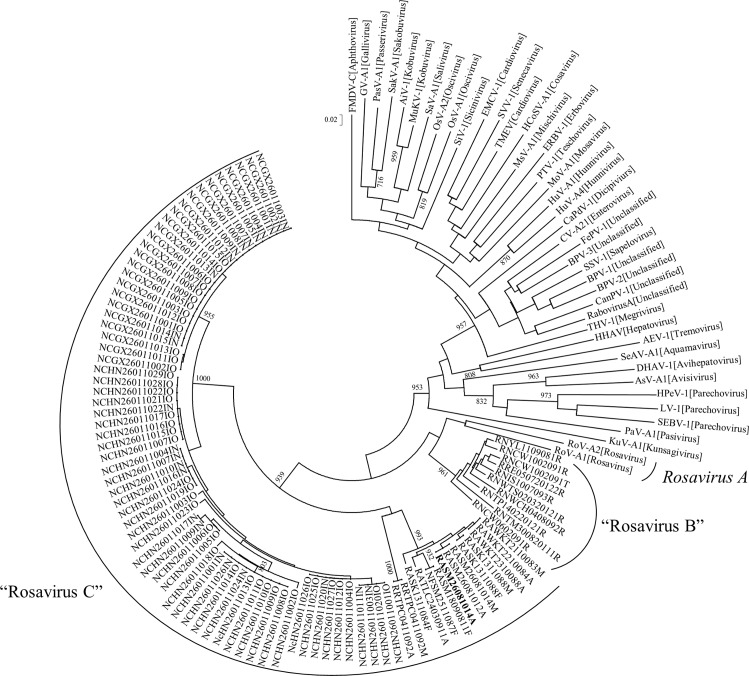
Phylogenetic analysis of nucleotide sequences of the 80-bp fragment (excluding primer sequences) of 3Dpol gene of a picornavirus identified from rodents in this study.The strain RASM14A that was successfully isolated in 3T3 cells is in bold. The trees were constructed by neighbor-joining method with bootstrap values calculated from 1000 trees. Only values greater than 700 are indicated. The scale bar indicates the estimated number of substitutions per 50 nucleotides.